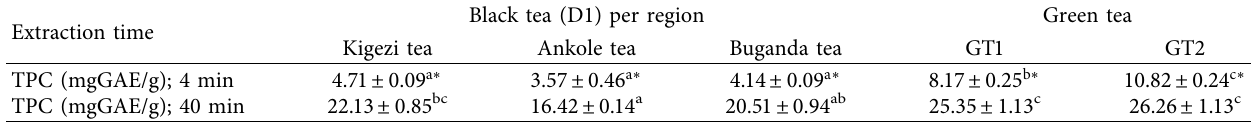
Table 2: Diferences in total phenolic content (TPC) of black tea per region/green tea brand. Extraction time